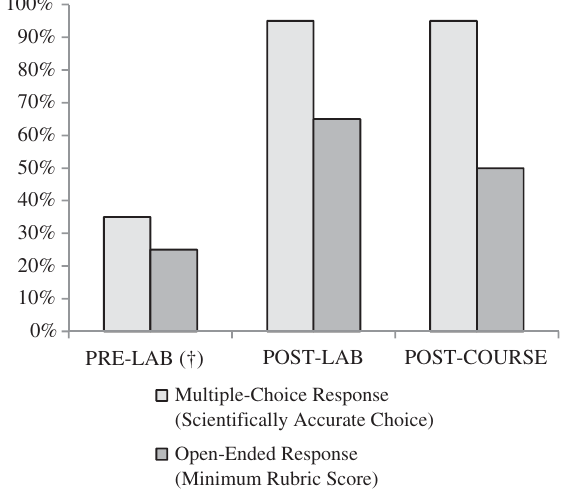
FIG. 7. Percentage of students meeting the minimum criteria when asked about the cause of the Moon ’ s phases ( n ¼ 23 ).